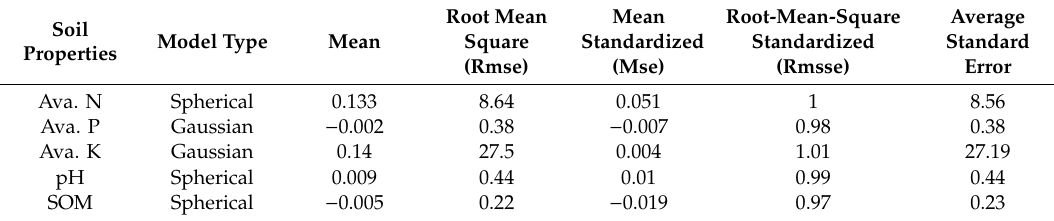
Table 6. Geostatistical analyses and semi-varogram